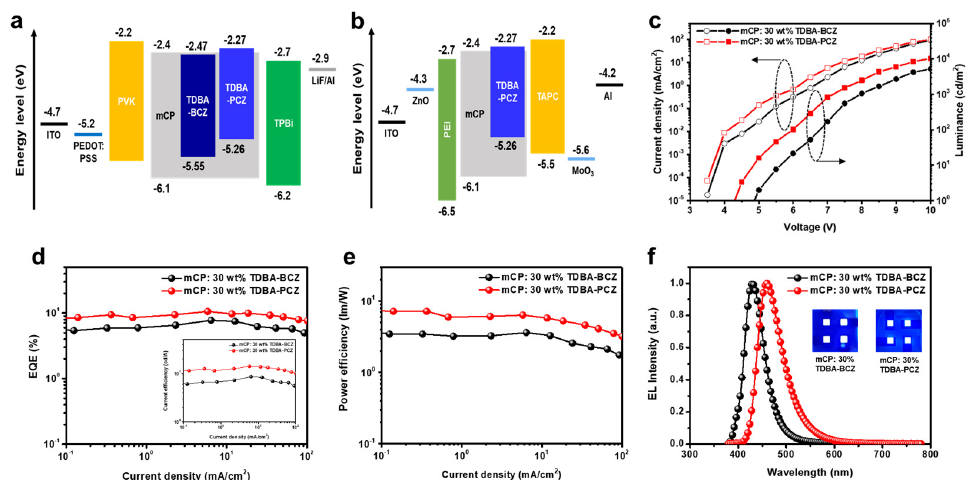
Figure 6. ( a ) Energy − level diagrams of a conventional forward device, ( b ) energy − level diagrams of an inverted device, ( c ) current density − voltage − luminance (J − V − L) curves of solution − process − doped OLED devices, ( d ) external quantum efficiency (EQE) vs. current density curves (inset: current efficiency vs. current density curves), ( e ) power efficiency vs. current density curves, and ( f ) EL spectra (inset: photographs of devices operating at 7 V). Table 2. EL performances of the solution-processed OLED